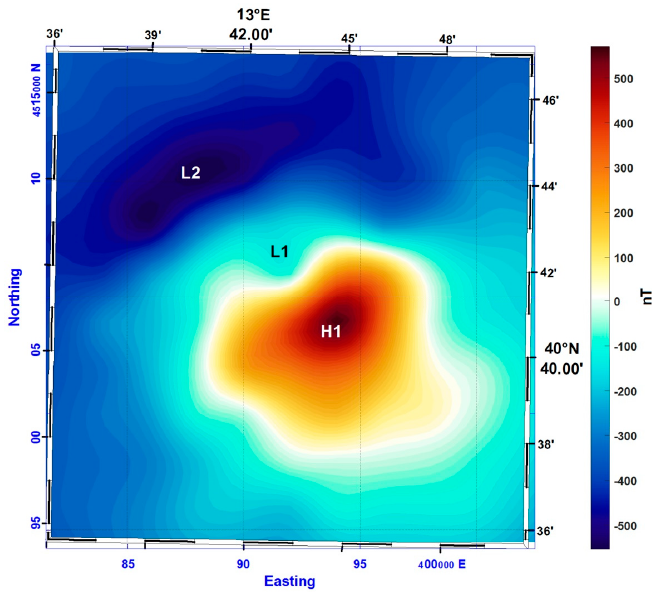
Figure 6. Total field aeromagnetic anomalies in the area west of Ischia Island, continued downward to sea level. Letters identify highs and lows of magnetic anomalies described in the text.